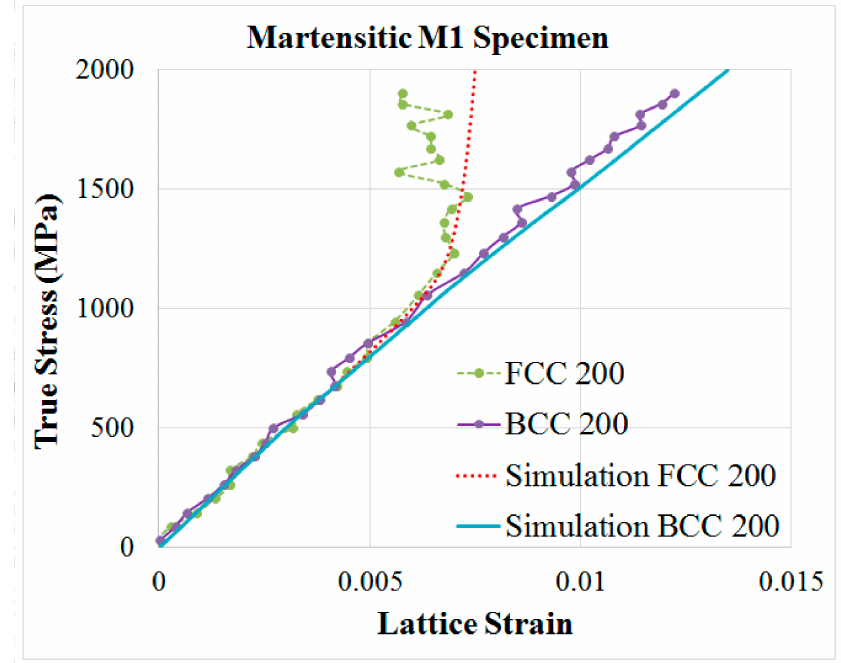
Figure 9. CPFE estimation and experiment results for lattice strains in the martensitic M1 specimen. Reproduced from [28], with permission of Elsevier